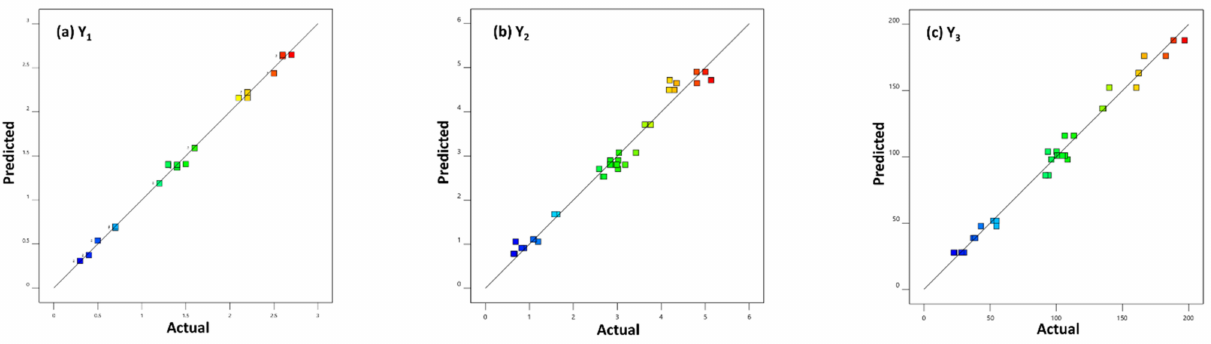
Figure 2. Correlation between predicted and experimental values of responses: ( a ) Y 1 (total yield); ( b ) Y 2 (thymol yield); ( c ) Y 3 (carvacrol